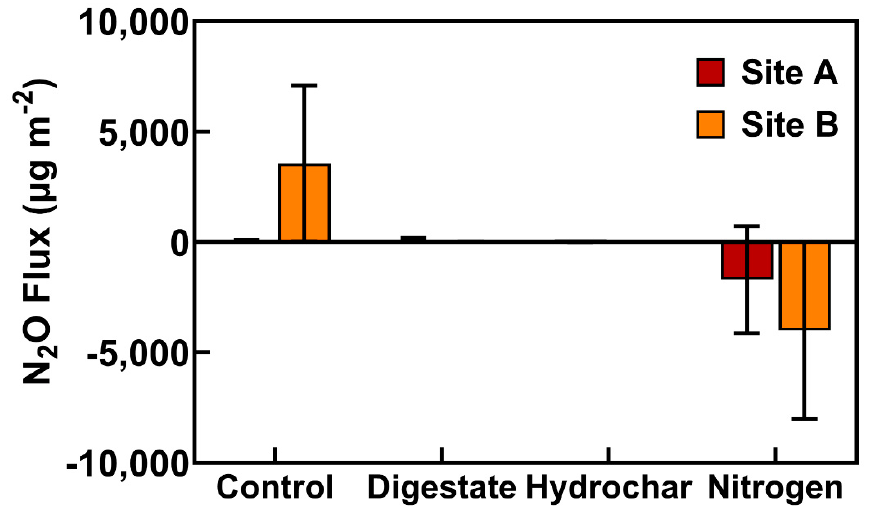
Figure 10. Cumulative N 2 O fluxes in µ g m − 2 from subplots in sites A and B treated with digestate,